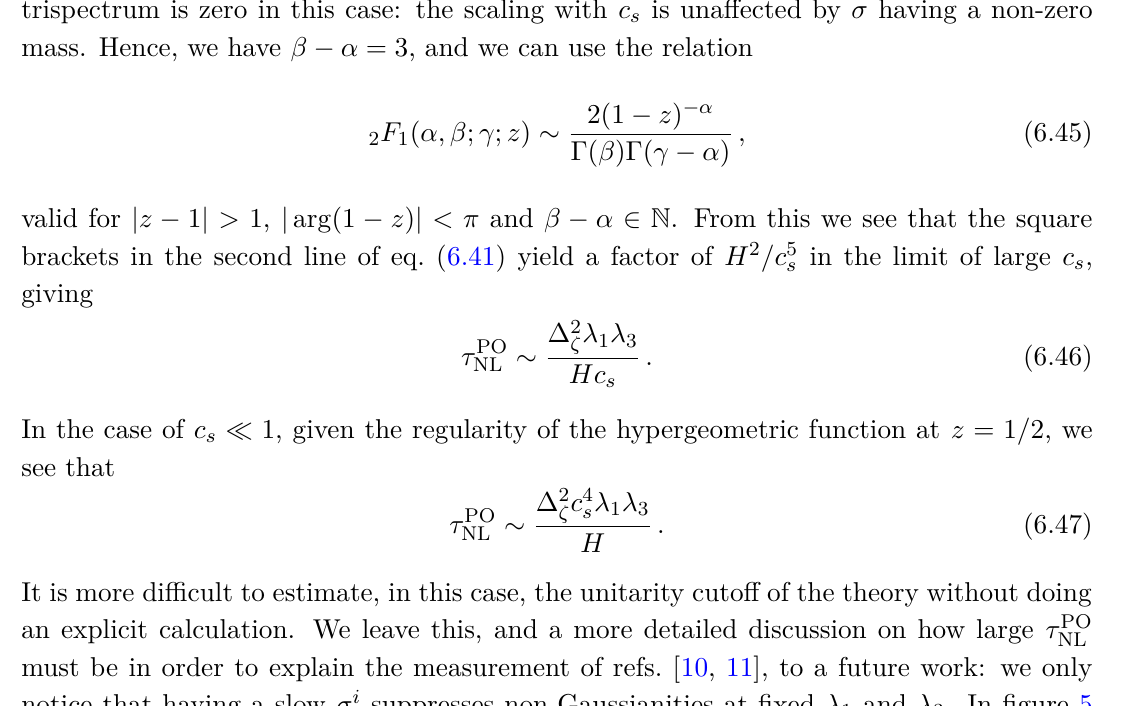
for the curvature perturbation ζ from the exchange of a spin- 1 field with mass m Figure 5 . τ PO NL and interactions λ and λ in eq. (6.8). Notice that the trispectrum vanishes for the conformally- 1 3 √ coupled mass m = 2 , in agreement with our general no-go σ /H